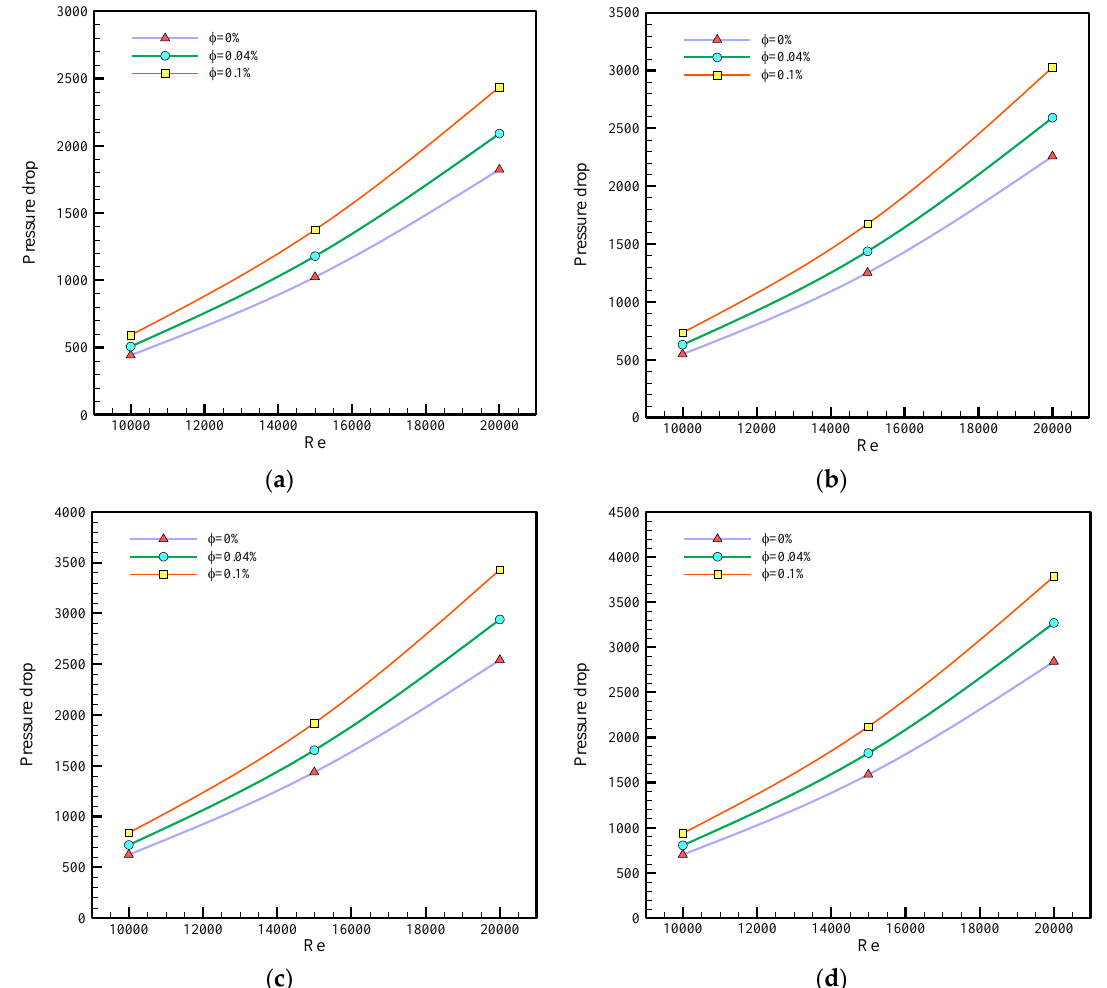
Figure 13. Pressure drop against Reynolds number at various solid volume fractions through the shell and tube heat exchanger with baffle angle of ( a ) 45°, ( b ) 90°, ( c ) 135°, and ( d ) 180°.